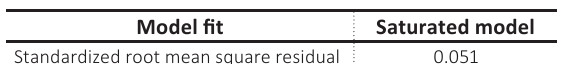
Table 5. Model fit